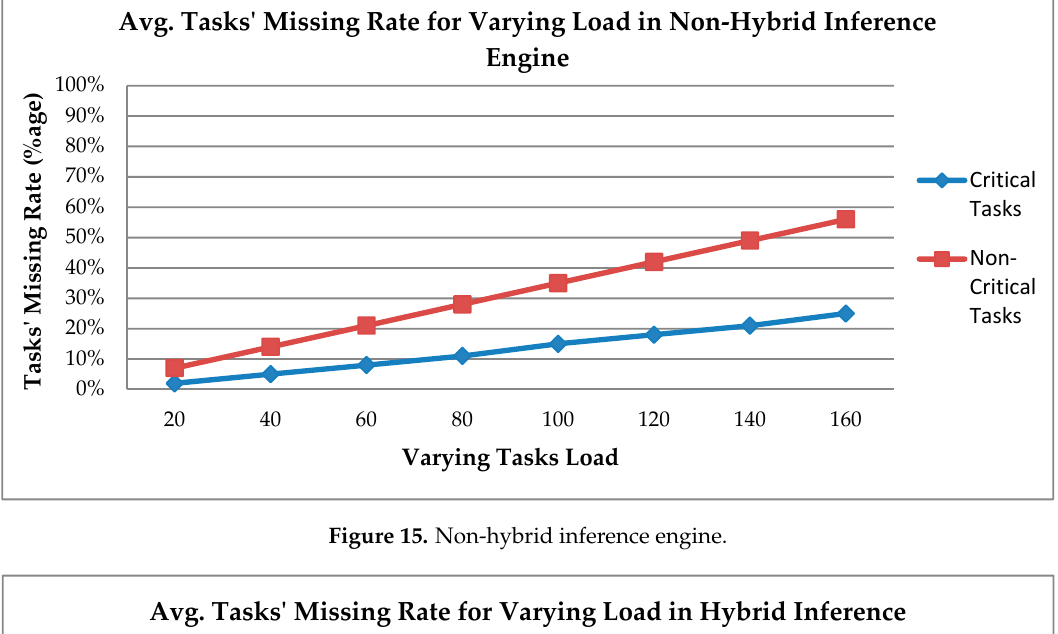
Figure 15. Non-hybrid inference engine.